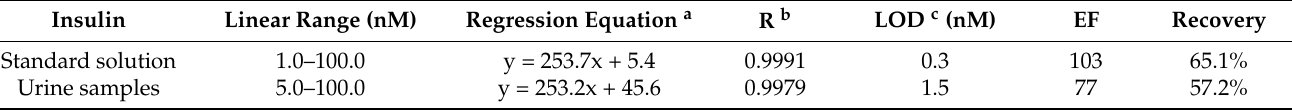
Table 1. Analytical characteristics for the determination of insulin.